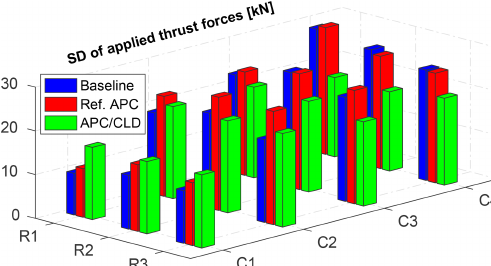
Figure 16. The standard deviation (SD) of the applied thrust forces on the individual wind turbines for the different APC approaches. R and C stand for the row and column of wind turbines, respec- tively, for our simulated wind farm (see Fig. 3). The power refer- = 12 . 3MW, b = 80%, and ence Eq. (23) is parameterized as P base farm c = 10%. The Ref. APC without CLD (red bars) and the APC with CLD (green bars) lead to almost the same accuracy of the wind farm power tracking (cf. Fig.